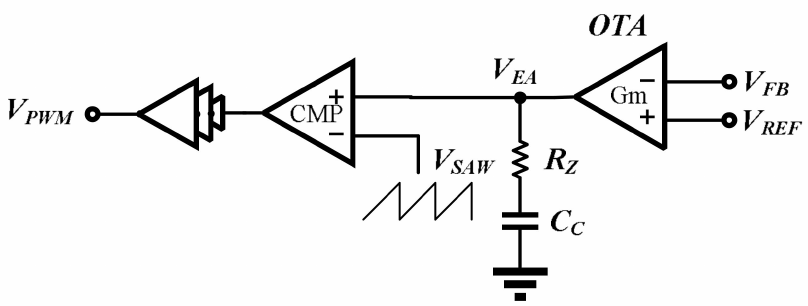
Figure 12. Pulse-width modulation (PWM) control